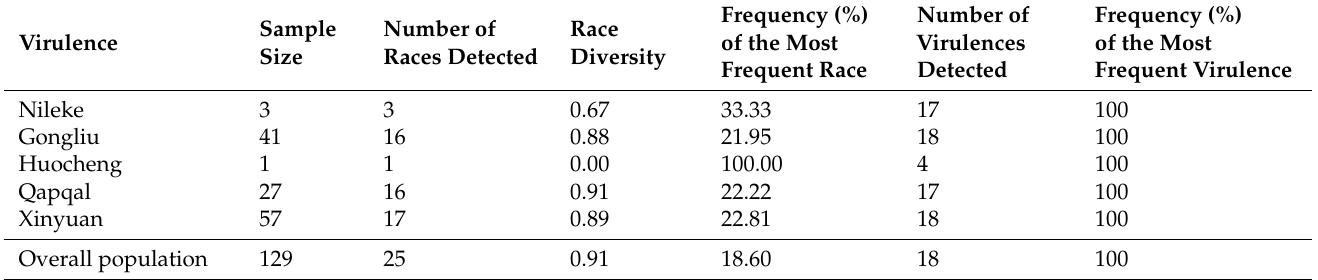
Table 3. Number of different pathotypes, virulences and their diversity detected in the Puccinia striiformis f. sp. tritici isolates collected from different locations in Xinjiang province of China in